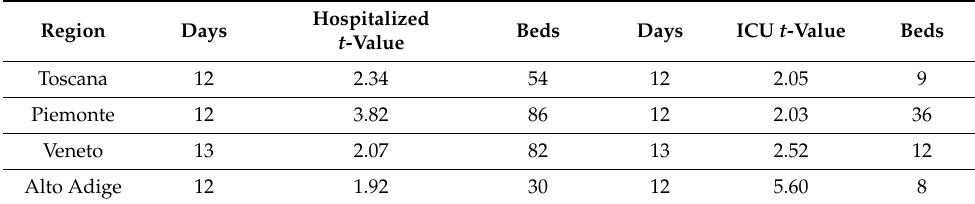
Table 1. This table presents the results of the regression models with Seasonal Auto Regressive Moving Average (SARIMA) errors concerning patients admitted in hospitals and intensive care units for Toscana, Veneto, Alto Adige, and Piemonte regions. The columns Days and Beds indicate the TPR predictive capacity in days (with the associated t -value) and the estimated variation of beds in both hospitals and Intensive Care Units (ICUs).